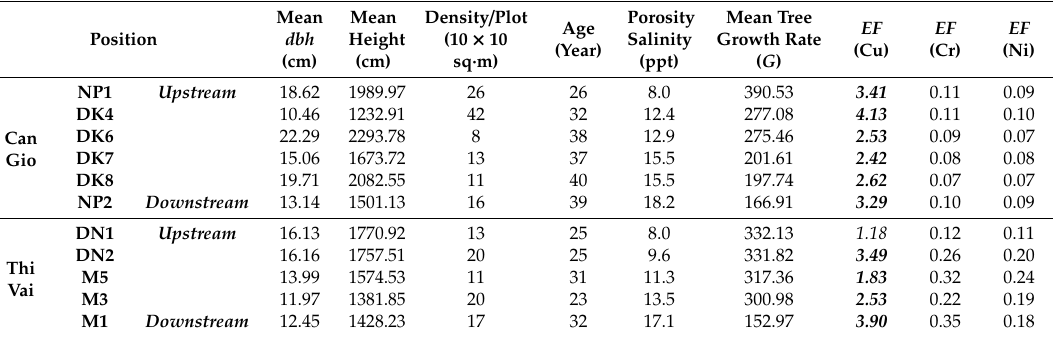
Table 2. Values of tree growth parameters and environmental factors at the 11 measurement plots.